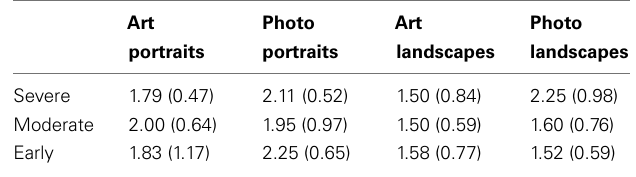
Table 3 | Esthetic stability as a function of disease severity for each stimulus